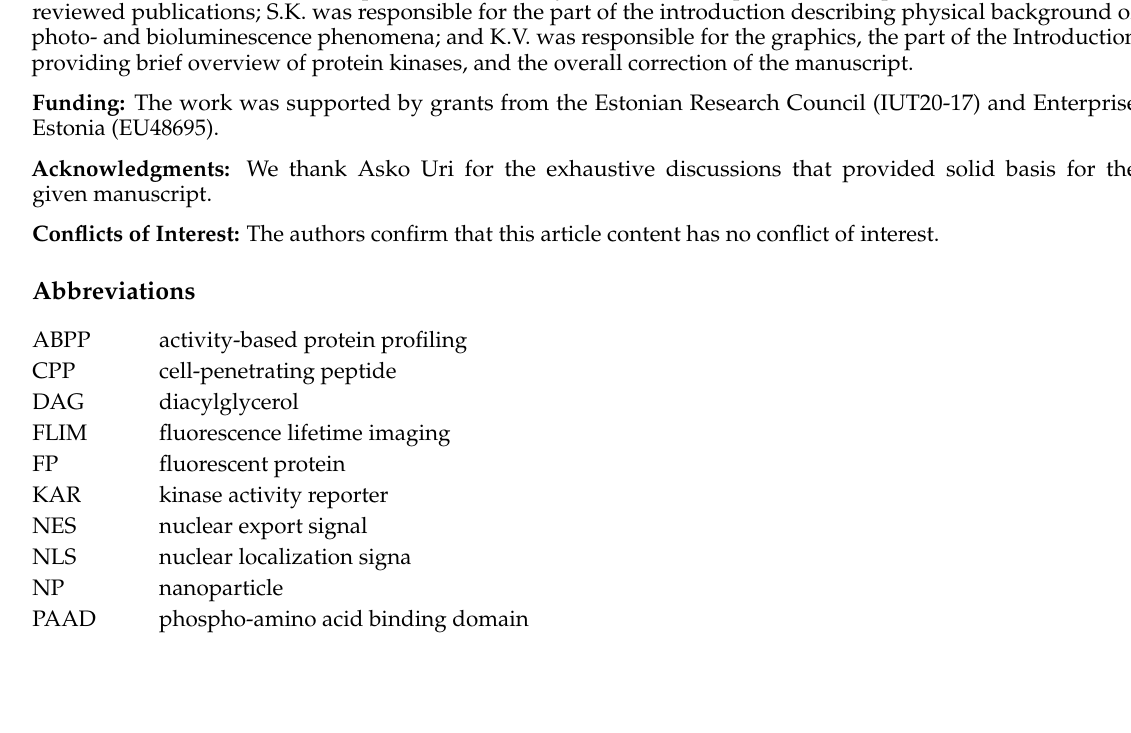
Table S1: structures and properties of various Class 1B probes, Table S2: structures and properties of various Class 3A probes, Table S3: structures and properties of various Class 3B probes, together with Supplementary